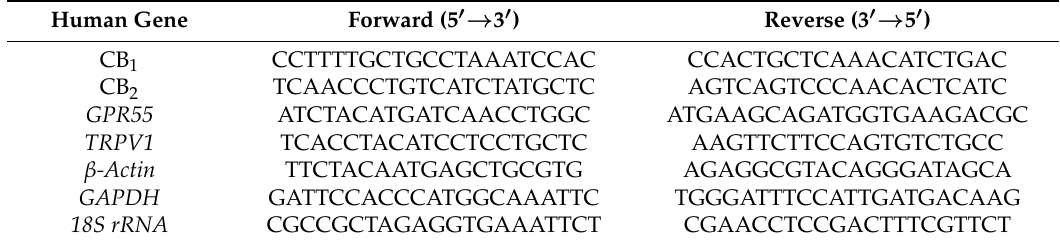
Table 4. List of primer sequences used for qRT-PCR